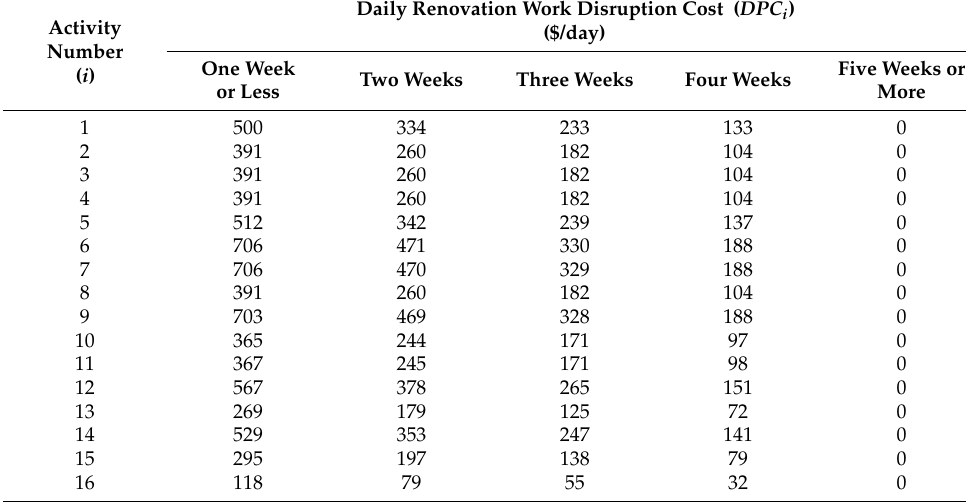
Table 3. Renovation work disruption